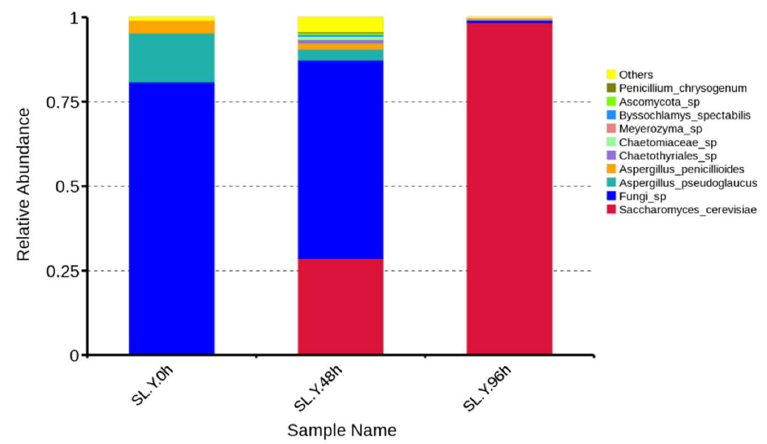
Figure 9. The histogram of the relative abundance of fungal species at the species level. Abscissa (left to right): 0 h, 48 h, and 96 h fermentation samples; ordinate: relative abundance of species. “Others” represents the sum of the relative abundances of all species outside the top ten.